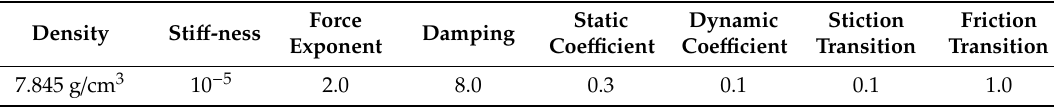
Table 6. The physical properties of magnetorheological pads [23].